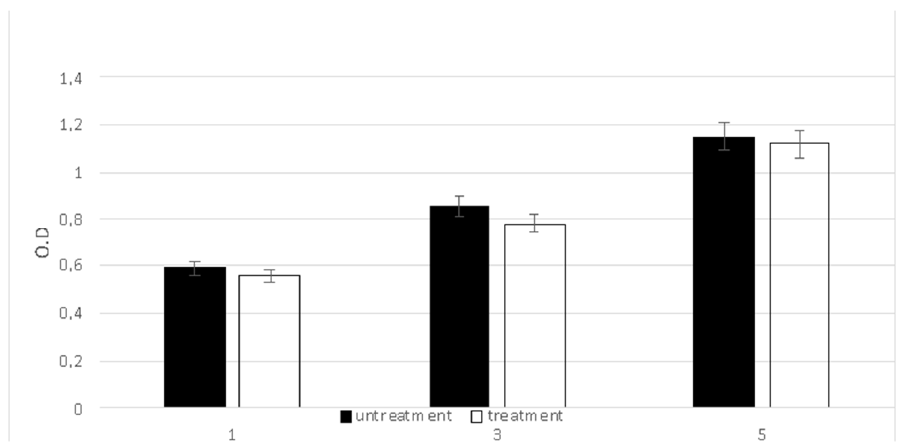
Figure 1. The viability of cells after the CMF treatment with the MTT assay at 1, 3 and 5. Cells cultured in the plastic culture dish were used as control. Data are given as the mean ± standard deviation (n = 3 per group).